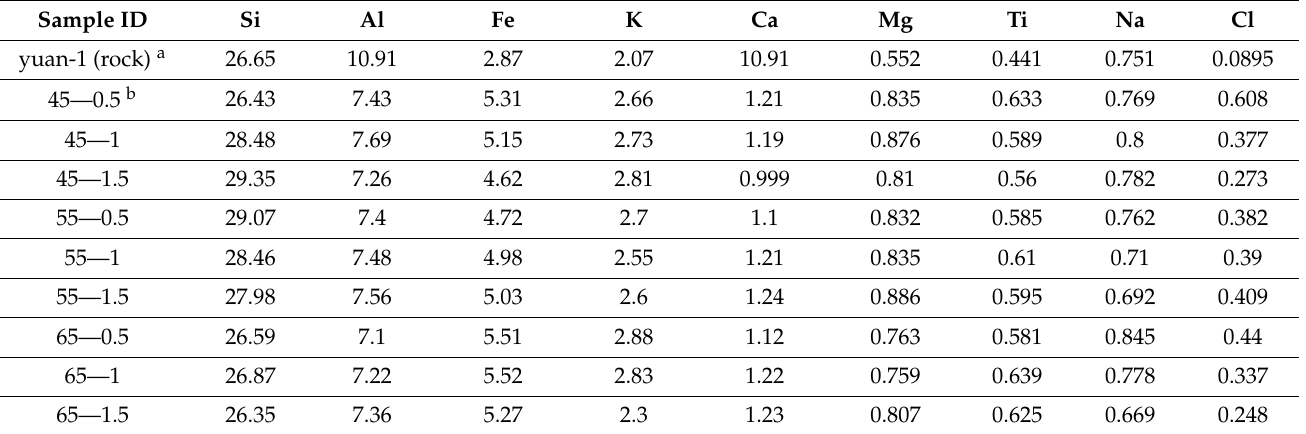
Table 4. Contents of major elements in ground sandstone specimens before and after water–rock